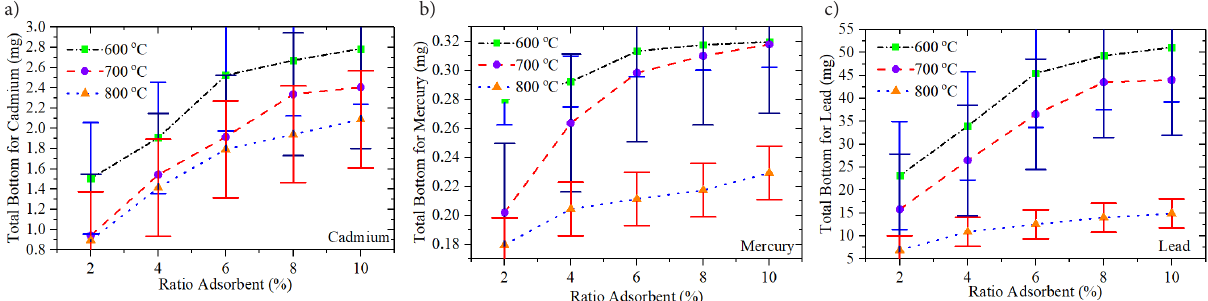
Figure 4. Total Cd, Hg, and Pb metal based on the adsorbent ratio for different temperatures